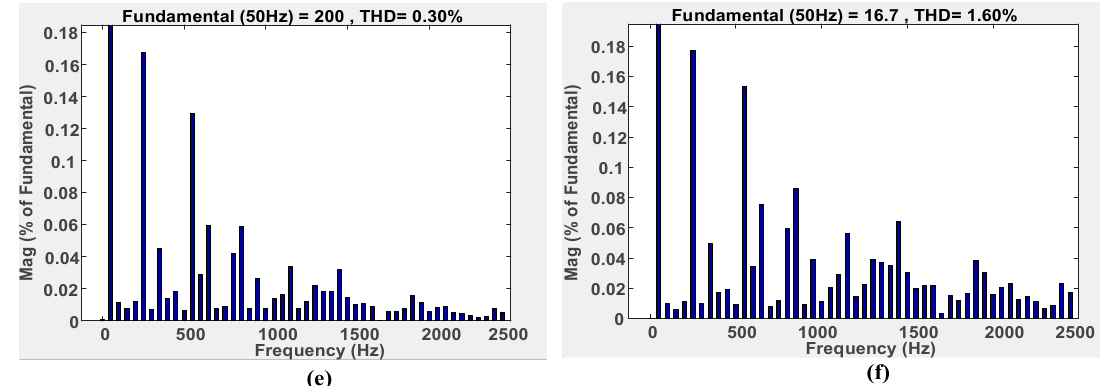
Figure 6. Simulation results with the H ∞ robust controller in steady-state condition. ( a ) Output voltage, ( b ) Load current, ( c ) α -frame voltage waveform, ( d ) Voltage tracking Error, ( e ) Voltage THD, ( f ) Current THD.